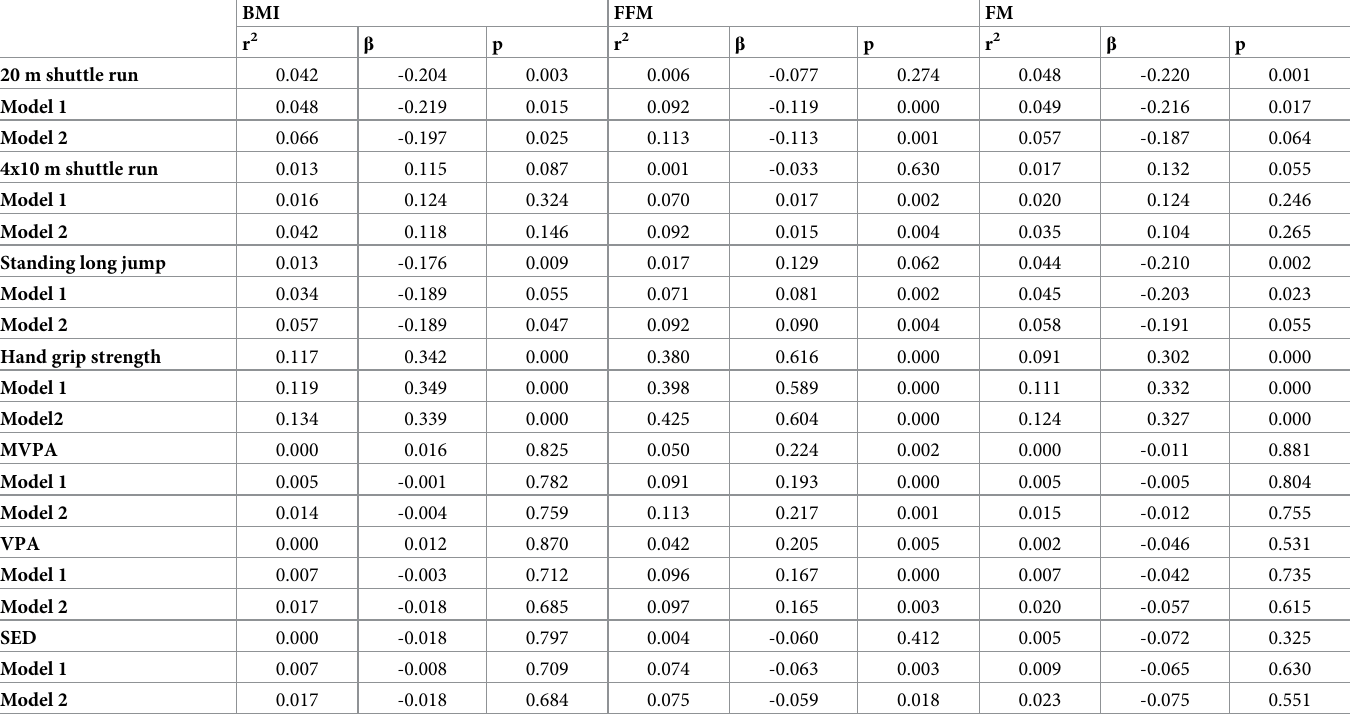
Table 3. Associations of physical fitness and physical activity with body composition values.